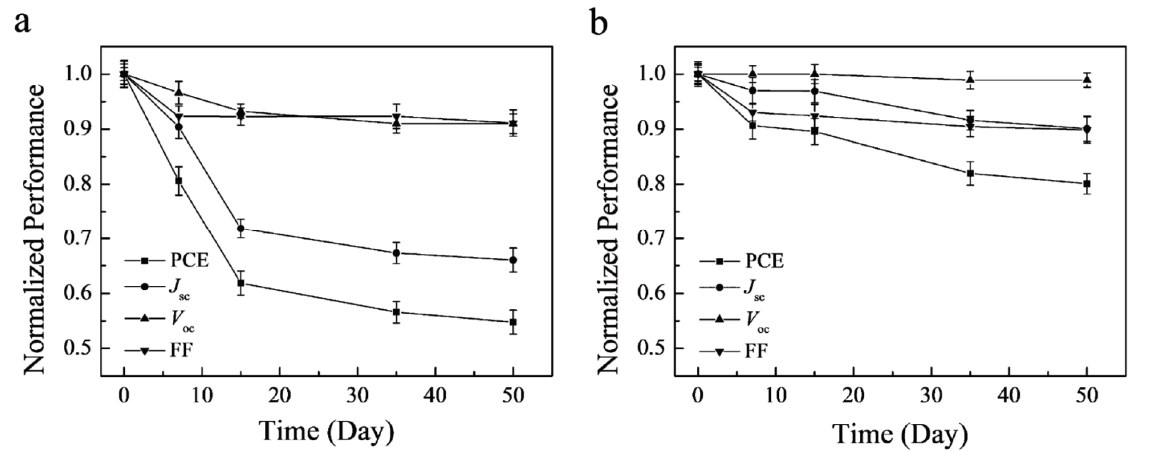
Figure 4. Dependence of the normalized device performance characteristics on storage time. ( a ) AI 4083 PEDOT:PSS device; and ( b ) UV-ozone and oxygen plasma treated Jet N PEDOT:PSS device. Reprinted with permission from [56]. Copyright 2014